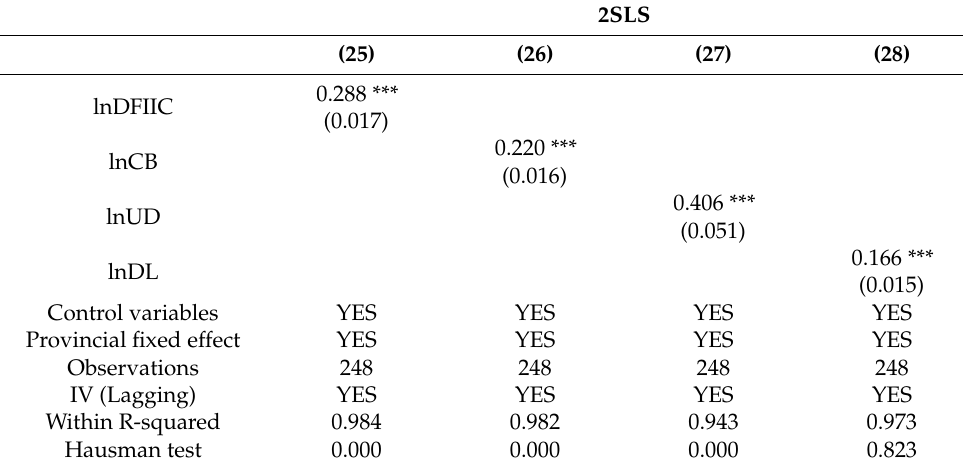
Table 6. Robustness check (IV).